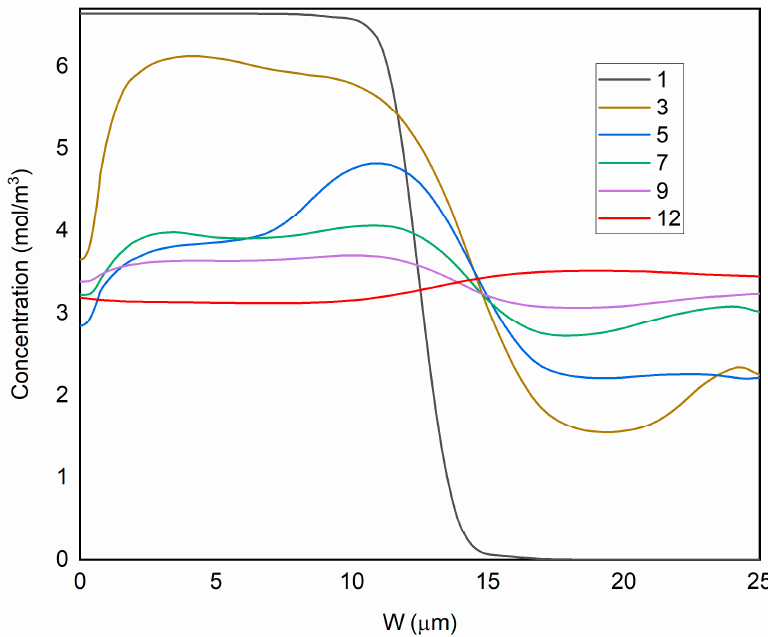
Figure 4. Concentration profiles at six positions (probe points #1, 3, 5, 7, 9, 12) across the width of the serpentine micromixer. The concentration curve at the inlet (#1, black) shows two distinct solutions with a sharp concentration gradient at the interface. The concentration curves flatten approaching the outlet and are almost completely flat near to the outlet point of the liquid jet (#12, red) indicating enhanced mixing induced by the chaotic advection effect of the serpentine geometry.